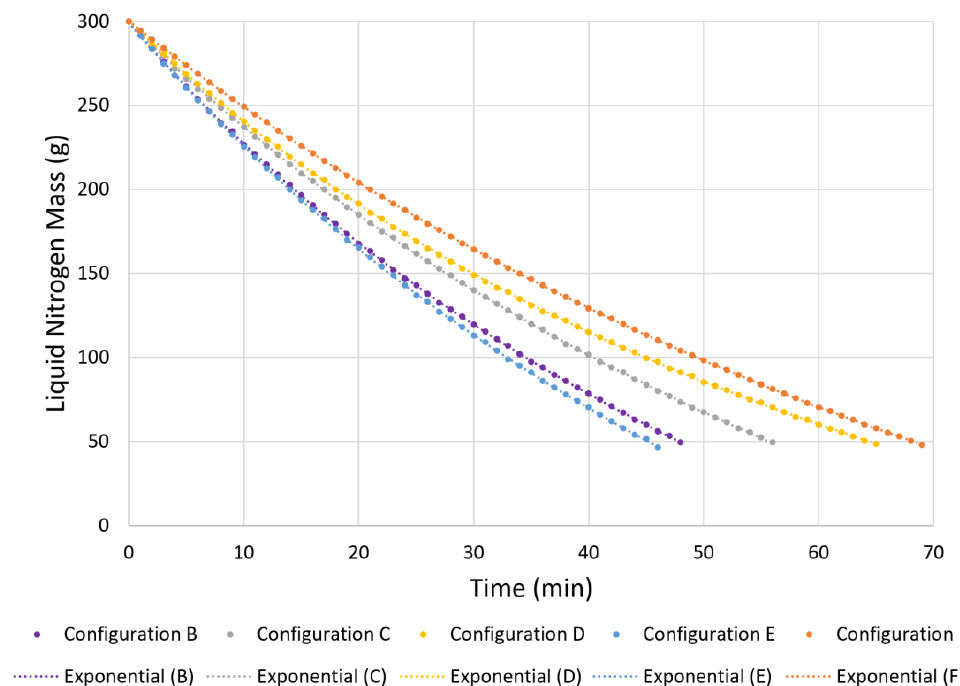
Figure 3. Evaporation rates for modified experimental Dewar configurations B, C, D, E, and F. Each curve is the average of four data runs, with data plotted in one-minute increments. Each data point’s associated y-axis standard deviation (SD) is contained in Appendix A. All curves start at 300 g of LN2 and continue until the first averaged data point is less than or equal to 50 g of LN2.